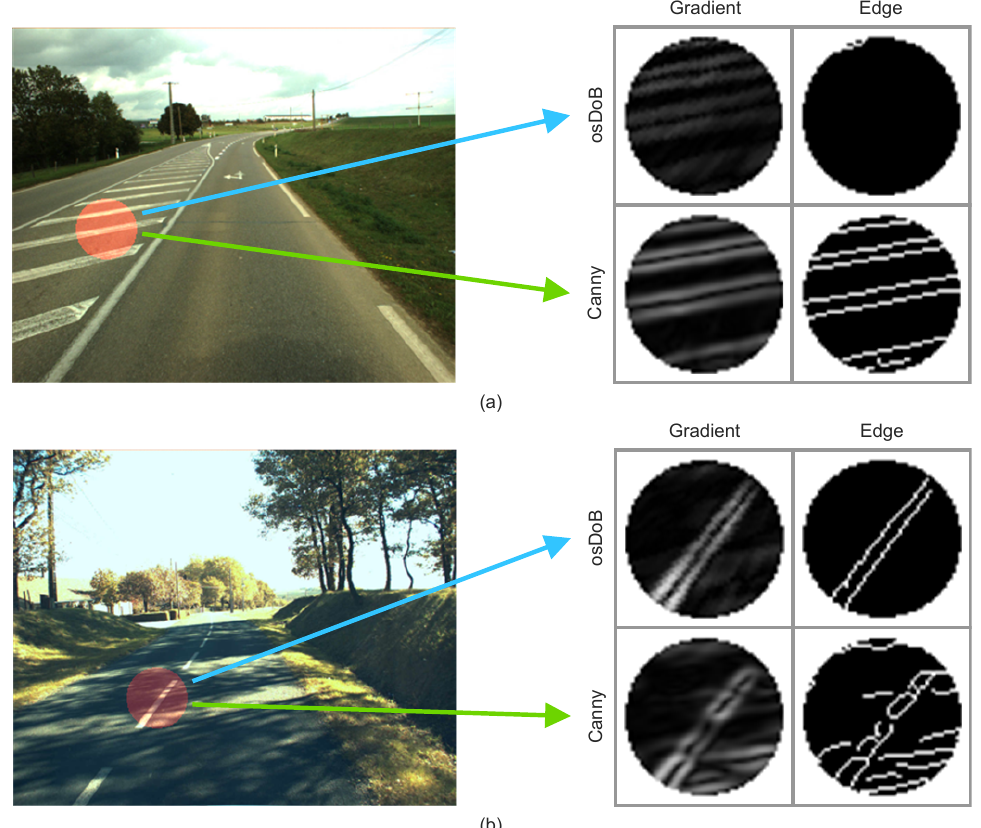
Figure 13. Illustration about the importance of orientation tuning. ( a ) Salient edges other than expected orientation appeared. ( b ) Multiple orientations caused by both of the lane markings and the shadows.